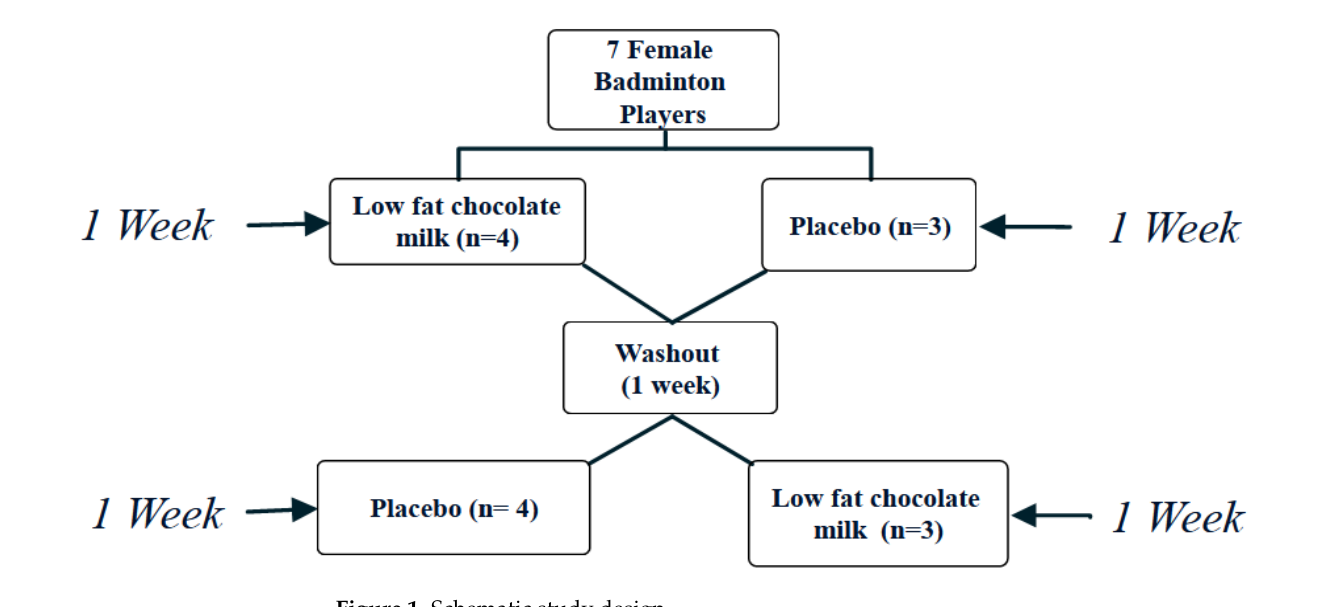
Figure 1. Schematic study design. Table 1. Energy and nutrient composition of LFCM (500 mL).